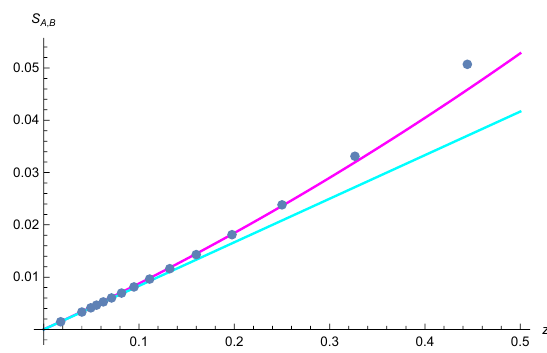
Figure 1 . Mutual information of two disks for 3 d free boson. The light blue curve is the theoretical result up to the leading order z . The pink line is theoretical result up to the next-to-leading order z 2 .